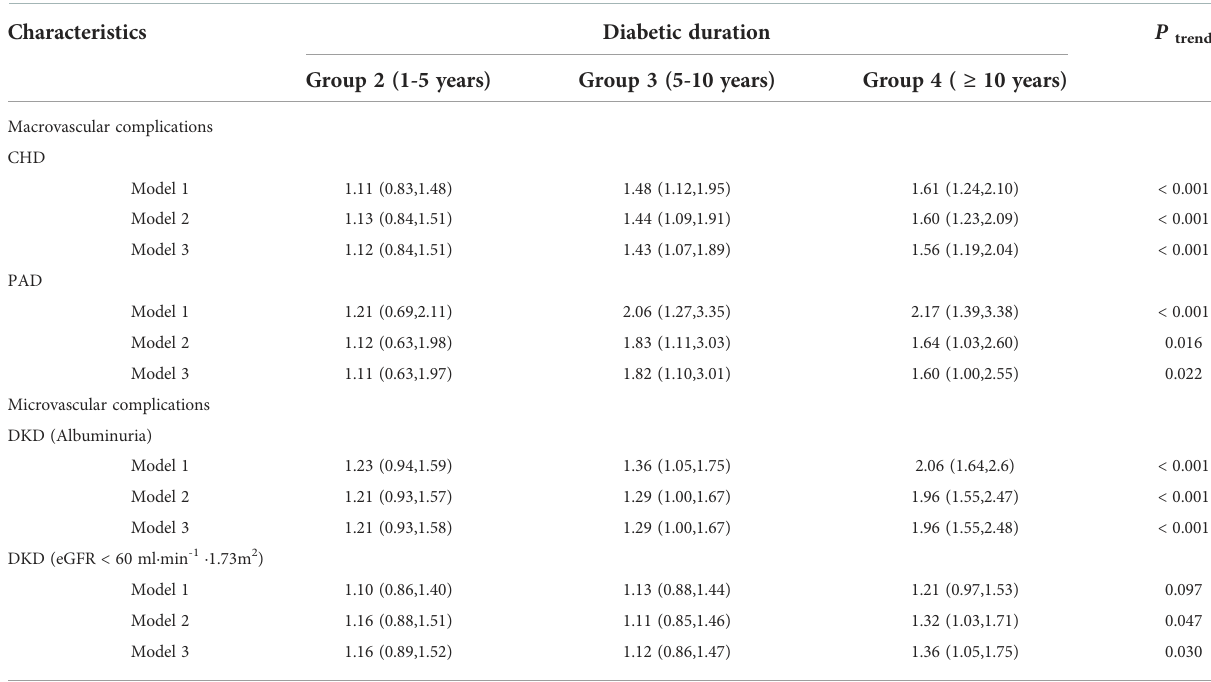
Model 1: unadjusted model. Model 2: adjusted for age, sex, education and BMI. Model 3: adjusted for age, sex, education, BMI, smoking and family history of